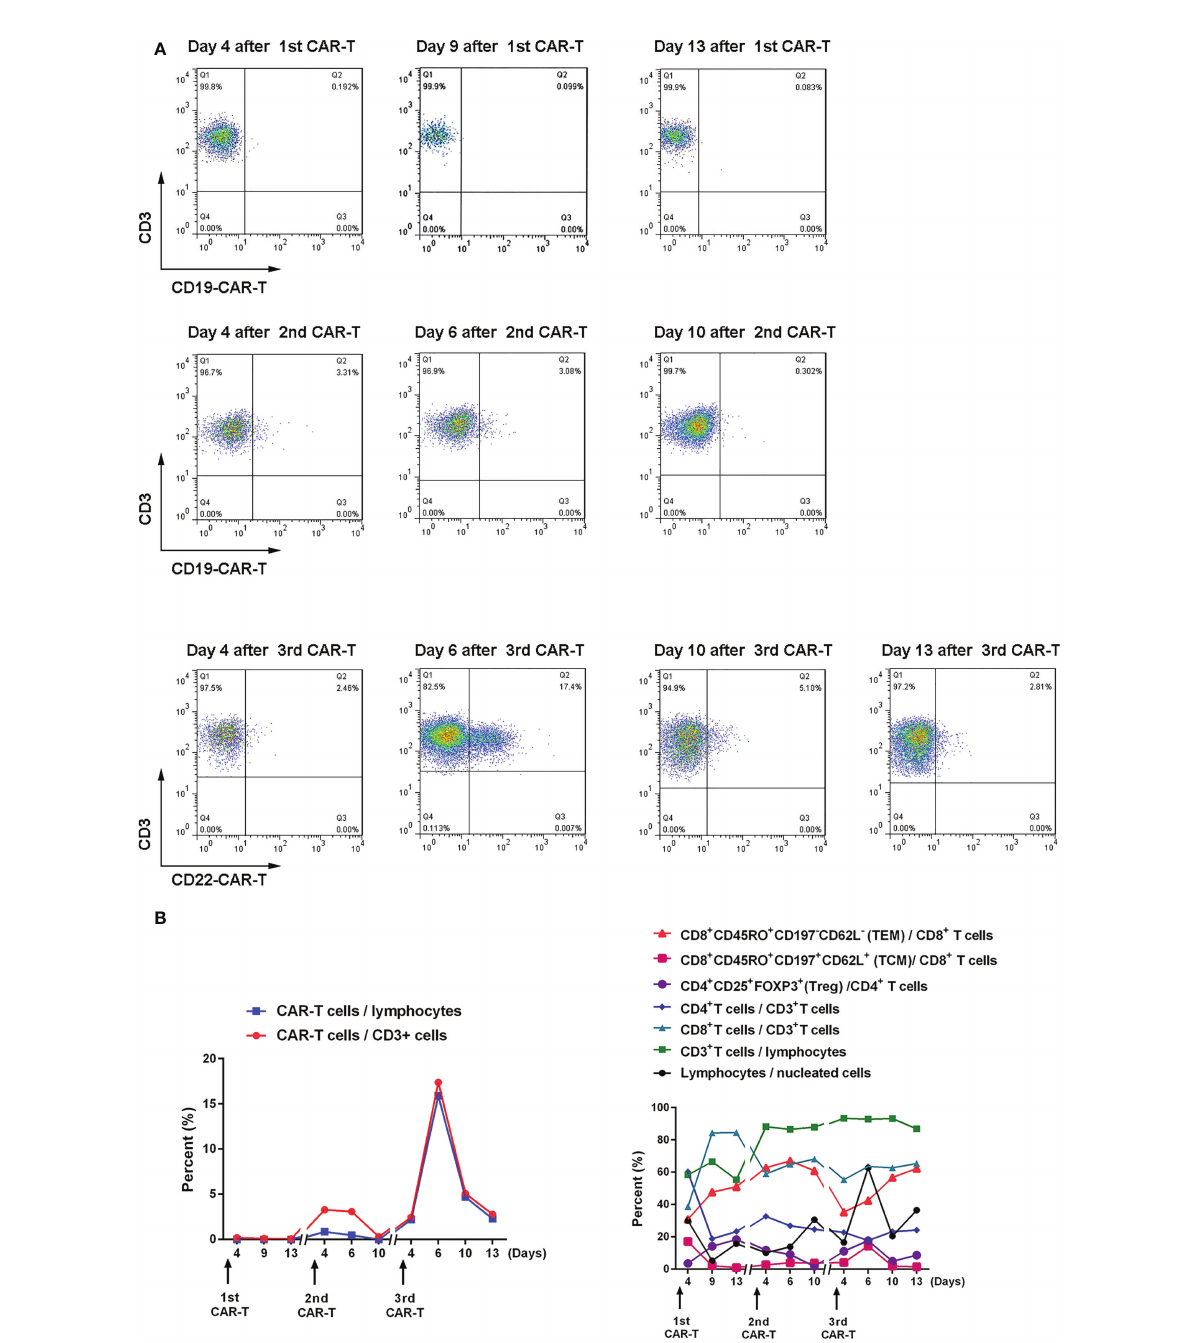
FIGURE 3 Expansion and changes of T cell subsets after CAR-T cell therapy (A) The proportion of CAR-T cells in CD3 + cells after CAR-T cell therapy was detected by fl ow cytometry. (B) Changes in the proportion of T cell subsets after CAR-T cell therapy. The memory phenotype is in bulk T